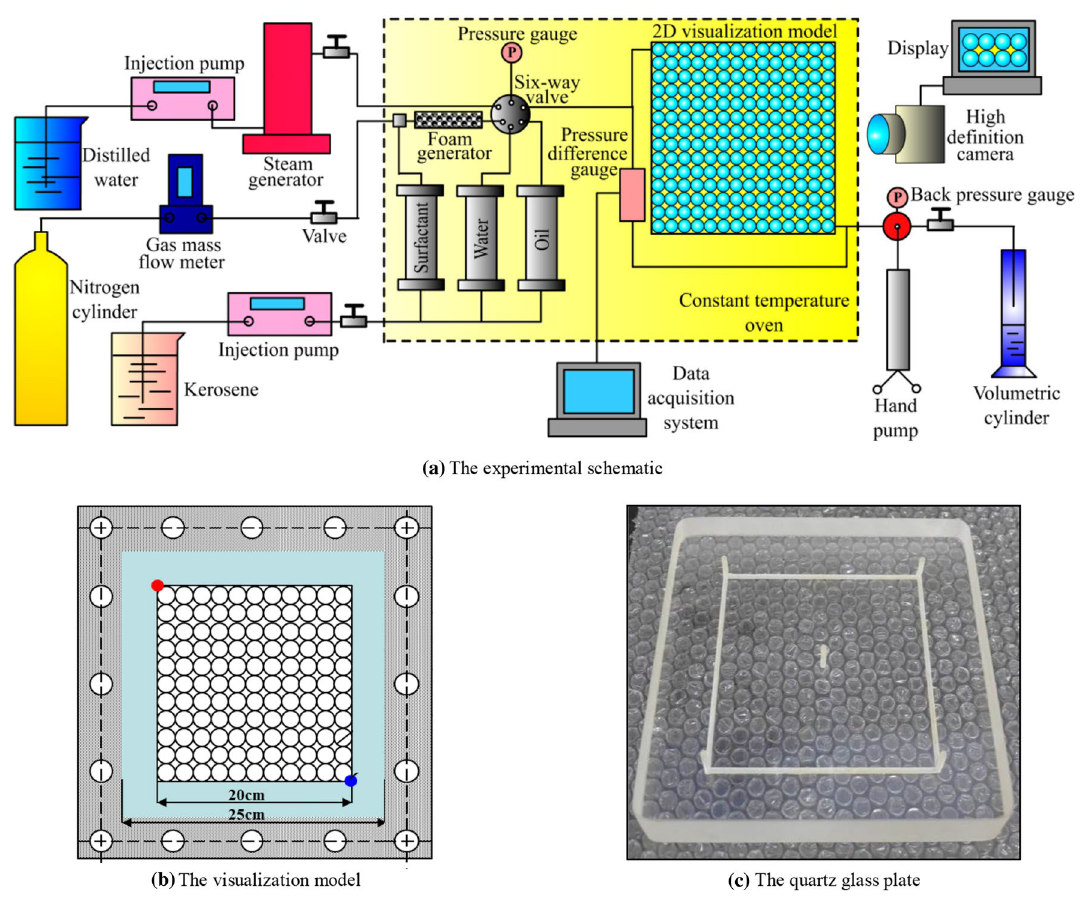
Fig. 3 The schematic diagram of visualization physical simulation Table 2 The experimental parameters of the visualization experiments